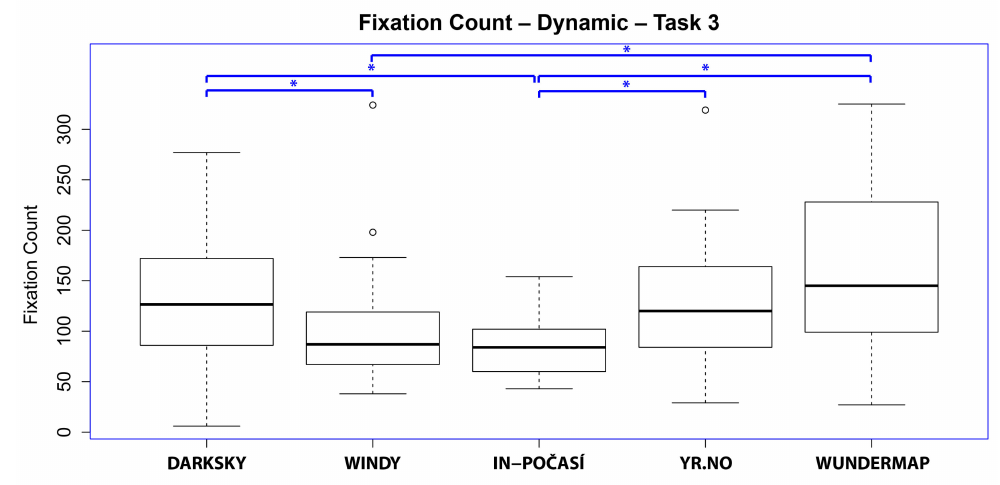
Figure 12. Fixation Count analysis in the Dynamic Section—Task